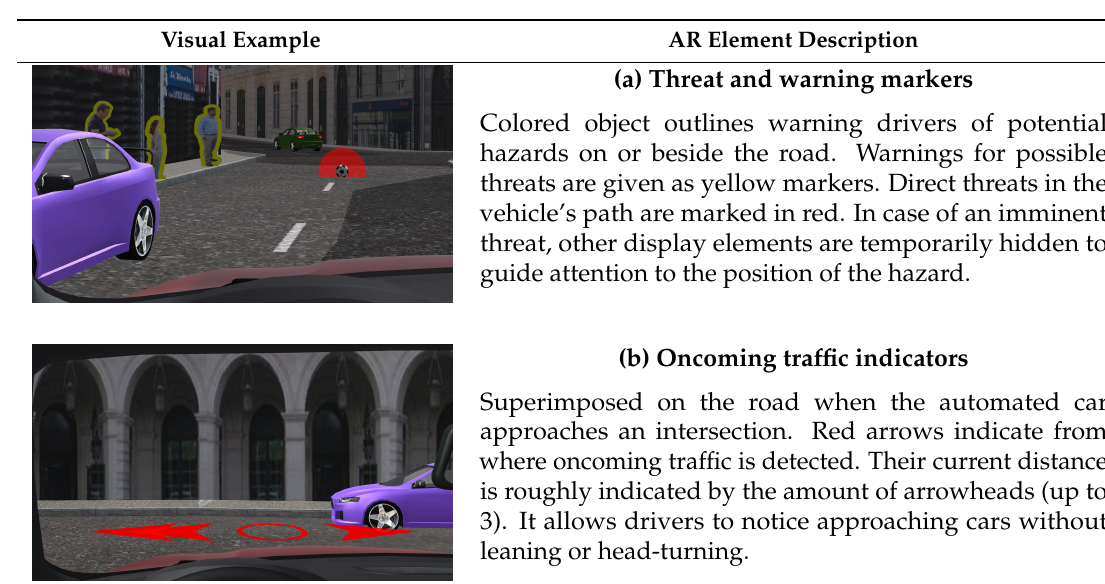
Table 1. An overview of the implemented AR elements with example visualizations and descriptions for each type or use case. For better visibility, screen-fixed elements are hidden, best viewed in color.